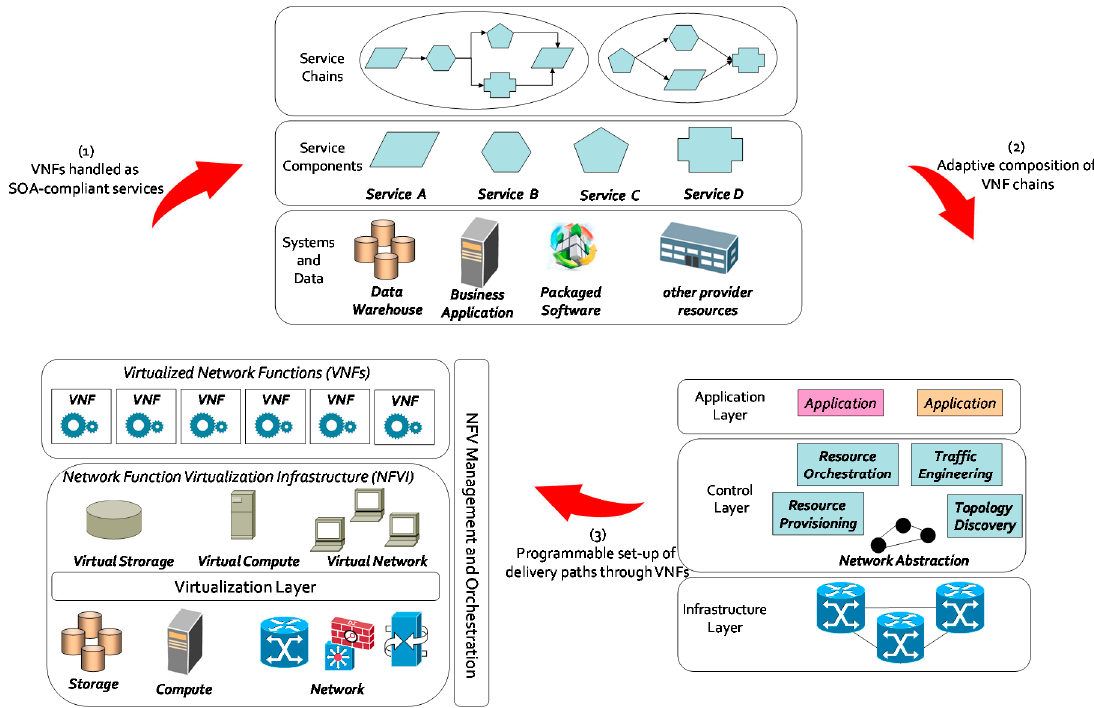
Figure 2. Service Oriented Architecture, Network Function Virtualization, and Software Defined Networking synergy for adaptive network service composition and delivery models.